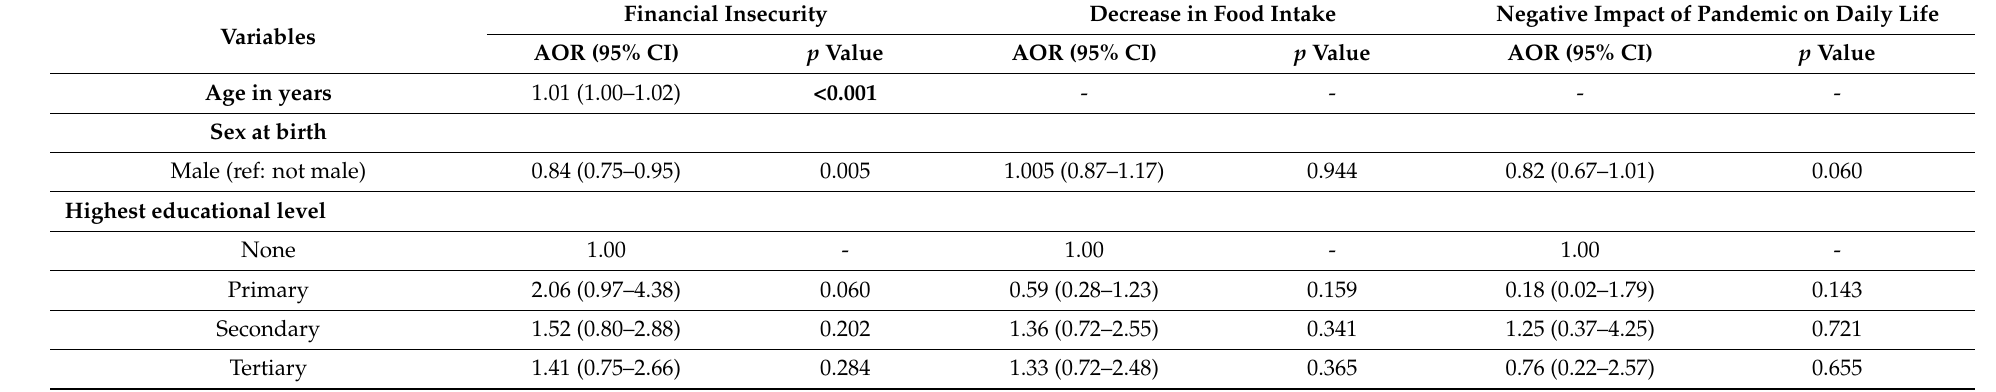
Table 2. Logistic regression analysis showing the factors associated with financial security, decrease in food intake and impact of the pandemic on daily lives of adults living in Nigeria during the COVID-19 pandemic ( N =